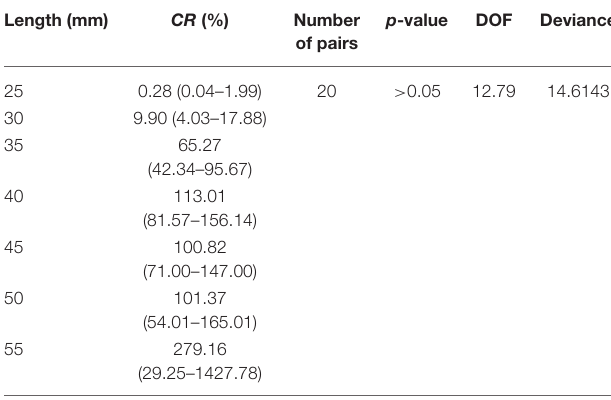
TABLE 3 | Catch ratio results at different lengths and fit statistics for the catch comparison analysis for krill. Length